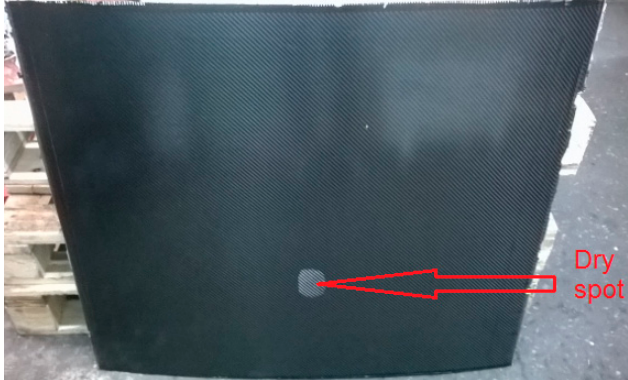
Figure 3. Defected CFRP panel after curing with dry spot.